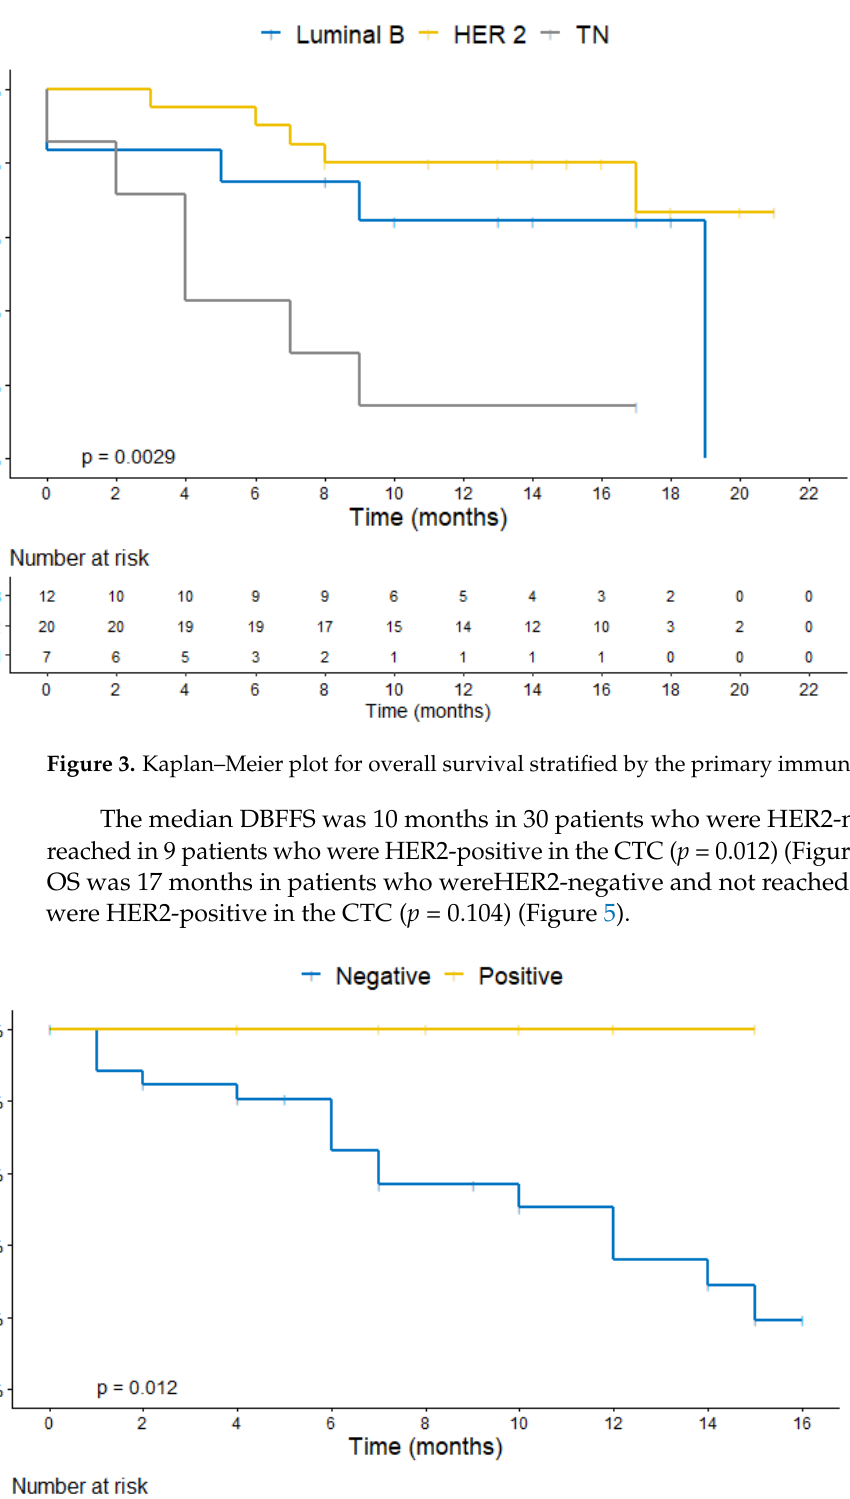
Figure 2. Kaplan – Meier plot for distant brain failure-free survival stratified by the primary immuno- phenotype.